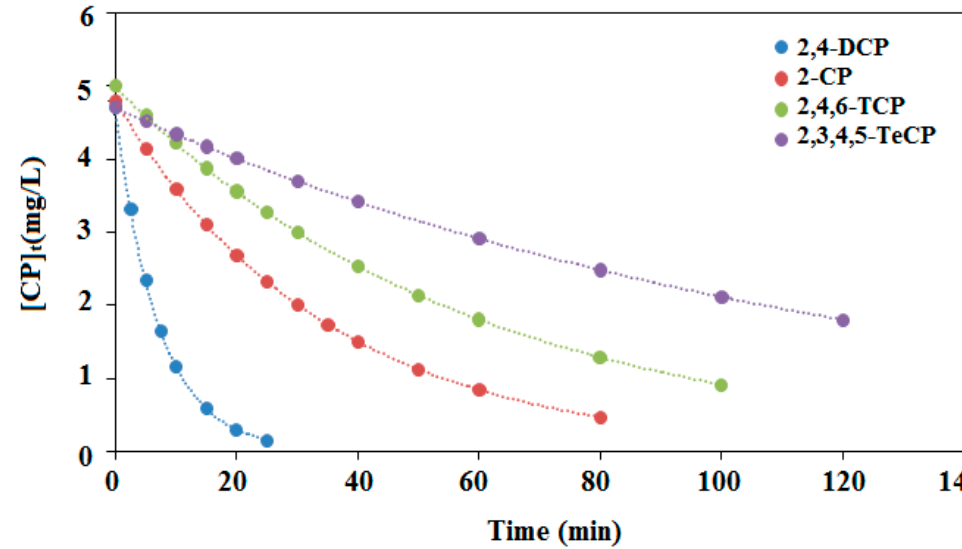
Figure 10. E ff ect of illumination times on the initial rates of photocatalytic mixture degradation (r 0 ) of chlorophenols (2-CP, 2,4-DCP, 2,4,6-TCP and 2,3,4,5-TeCP). (The initial concentration of each phenol 5 mg / L, at pH = 8.)